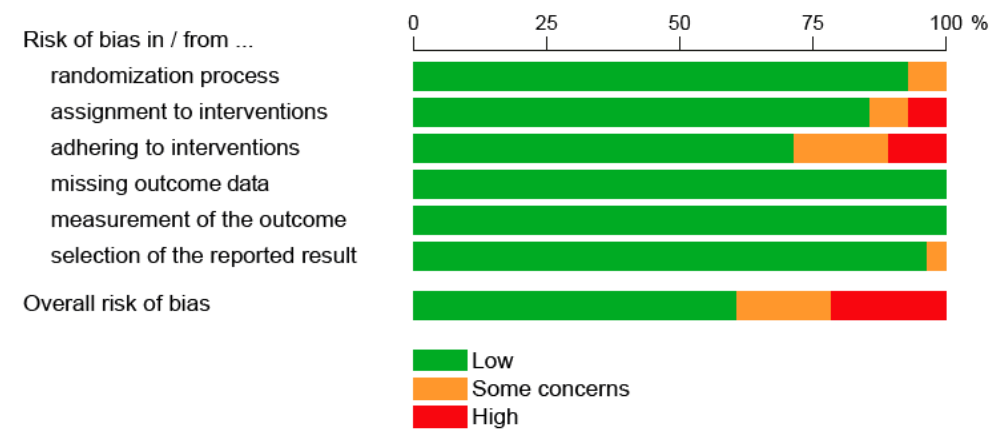
Figure 3. “Risk of bias” graph: Review authors’ judgements about each “Risk of bias” item presented as percentages across all included randomized controlled trials ( n = 28). See Figure 2 for details.